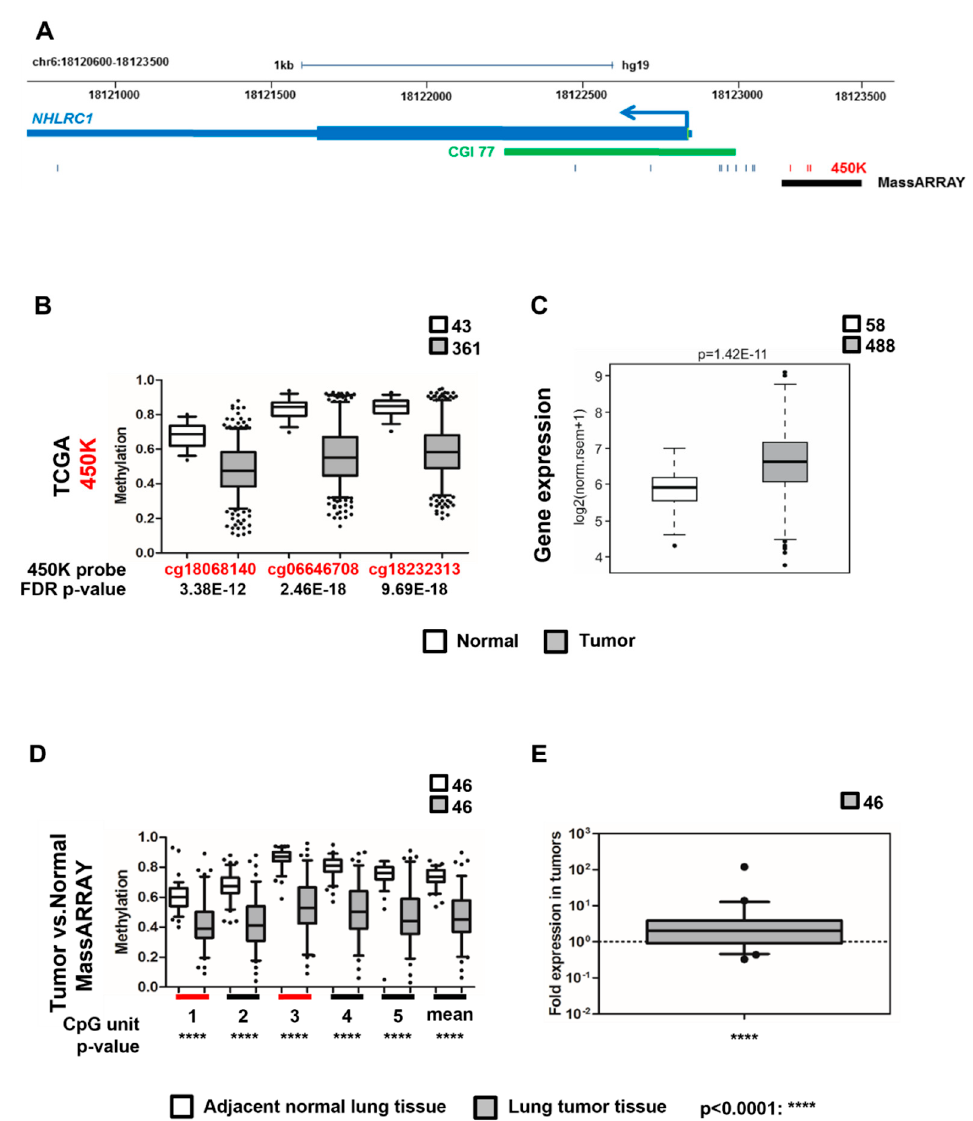
Figure 2. NHLRC1 DNA methylation and mRNA expression in lung adenocarcinomas. ( A ) Ge- nomic location of the NHL repeat containing 1 ( NHLRC1 ) gene. 256 bp region tested by MassARRAY and the 450K CpG probe positions are indicated. Red ticks depict differentially methylated 450K probes. ( B ) In silico TCGA tumor versus normal 450K data analysis for ADC for the candidate and 2 adjacent CpGs in the NHLRC1 DMR. False discovery rate (FDR) corrected p -values are displayed. ( C ) NHLRC1 gene expression of TCGA tumor versus normal data. ( D ) MassARRAY in 94 paired lung tumor versus 94 adjacent normal lung samples to determine DNA methylation of all CpGs in a 256 bp region displayed as CpG units. Red lines indicate those CpG units containing the CpGs which were originally identified as differentially methylated in EPIC and TCGA. Two-tailed t -test p -values. ( E ) NHLRC1 mRNA expression analysis by real-time PCR in 92 samples of the lung tumor versus adjacent normal sample set. Whiskers indicate 5–95 percentile. Two-tailed t -test p -values, ****: p <